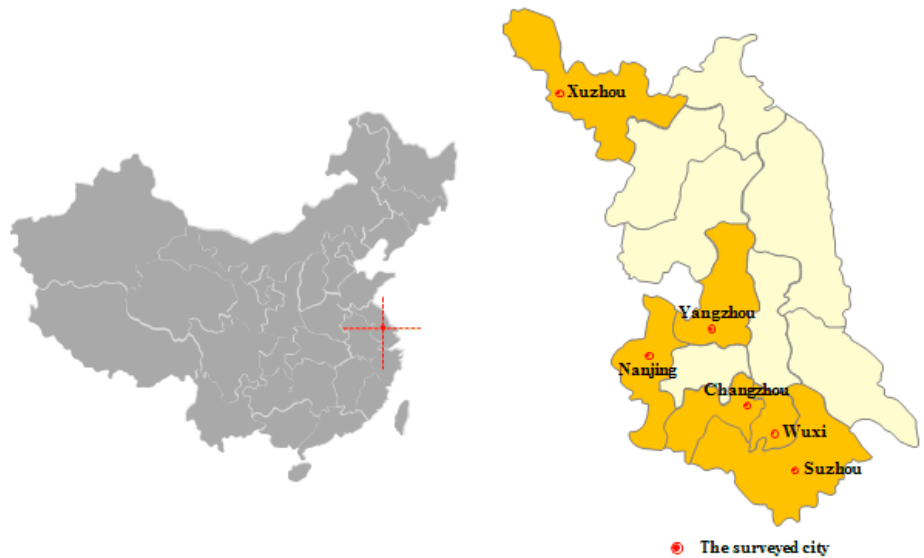
Figure 3. Surveyed cities in Jiangsu Province.